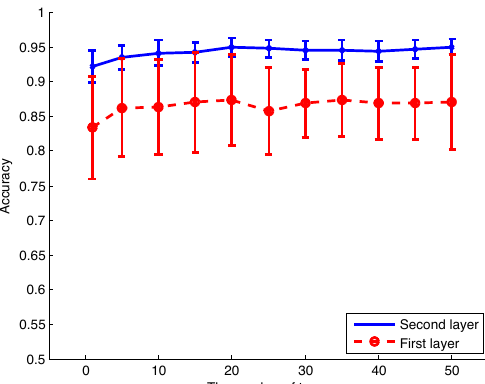
Figure 13. Mean accuracy and standard deviation of 10-fold cross-validation (CV) for different numbers of decision trees in RF. The number of trees includes 1, 10, 15, 20, 25, 30, 35, 40, 45, 50. The blue line is the performance of the second-layer RF, and the dash with circle is the performance of the first-layer RF.